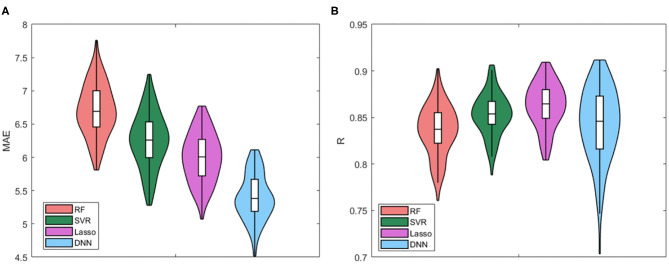
Violin plots of the distributions of (A) MAE values and (B) R values for the four models.